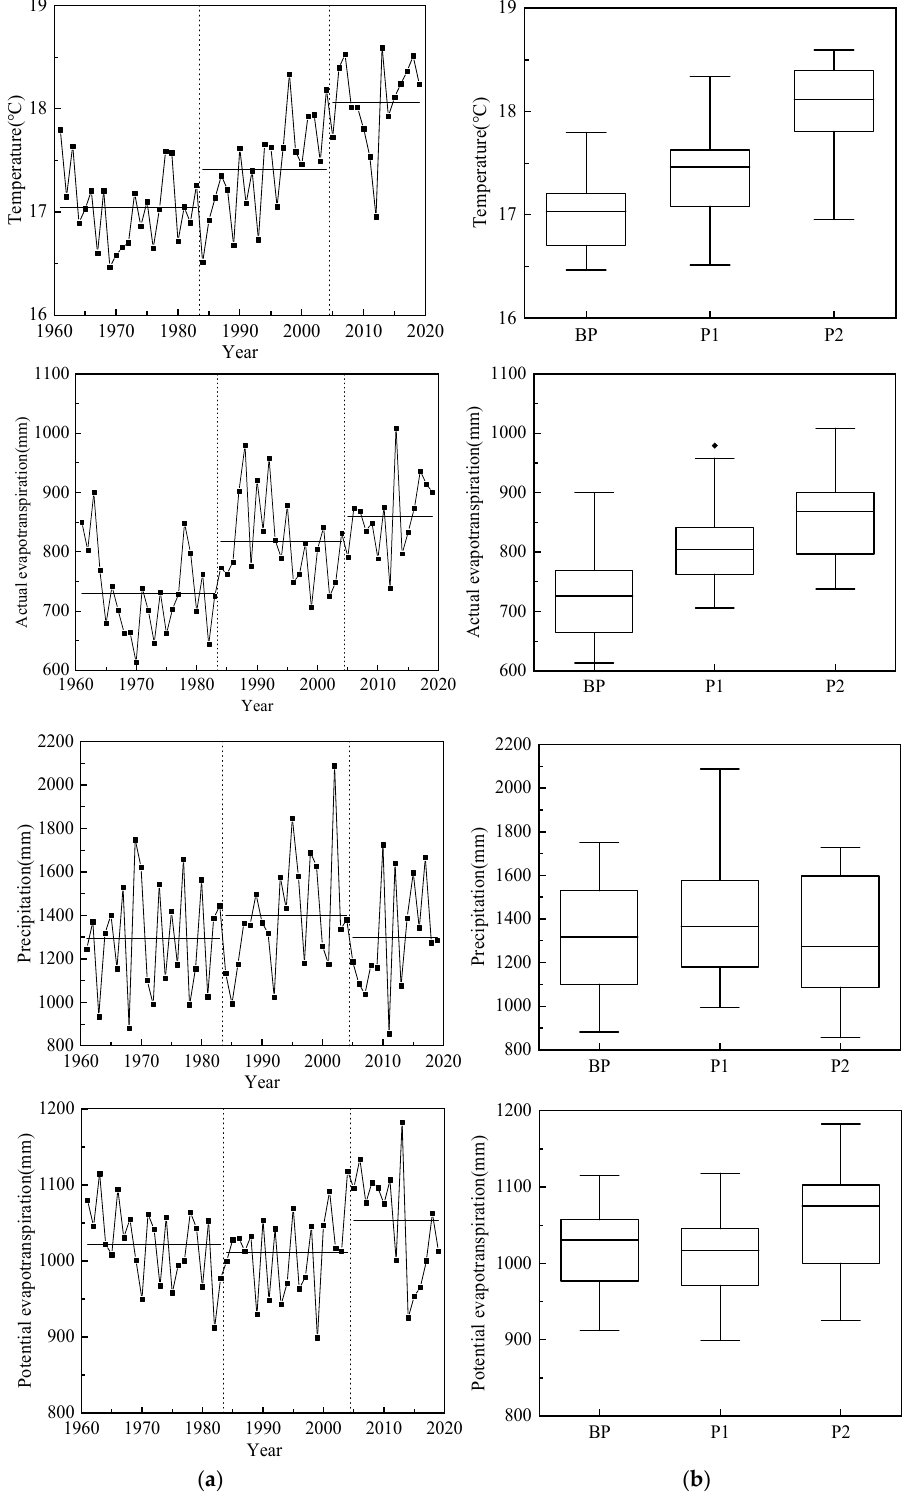
Figure 3. ( a ) Annual temperature, actual evapotranspiration, precipitation, potential Figure3. ( a )Annualtemperature, actualevapotranspiration, precipitation, potentialevapotranspiration, evapotranspiration, and runoff depth series; ( b ) Box plot of annual temperature, actual and runo ff depth series; ( b ) Box plot of annual temperature, actual evapotranspiration, precipitation, evapotranspiration, precipitation, potential evapotranspiration, and runoff depth in BP, P1, and P2. potential evapotranspiration, and runo ff depth in BP, P1, and P2. As shown in Figure 3, the average runo ff depth in BP is 565.14 mm. The average runo ff depth in P1 is 583.30 mm, which is 18.17 mm higher than that in BP. The average runo ff depth in P2 is 440.84